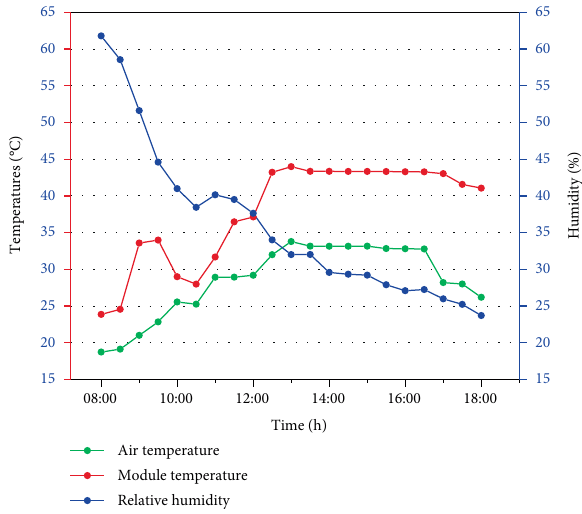
Figure 3: Comparison of two readings from two solar meters taken on a clear sky.